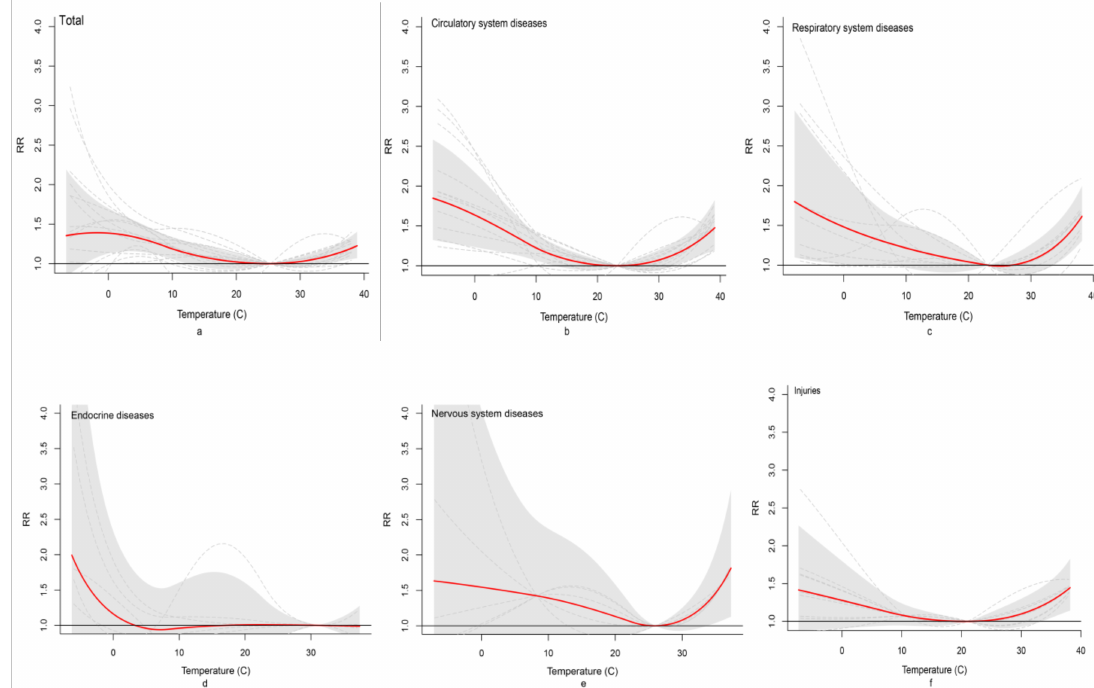
Figure 2. Overall exposure–response relationship between daily maximum temperature and cause-specific mortality by 30 d lag at 17 study sites in China: ( a – f ) total, circulatory system diseases, respiratory system diseases, endocrine diseases, nervous system diseases, and injuries,